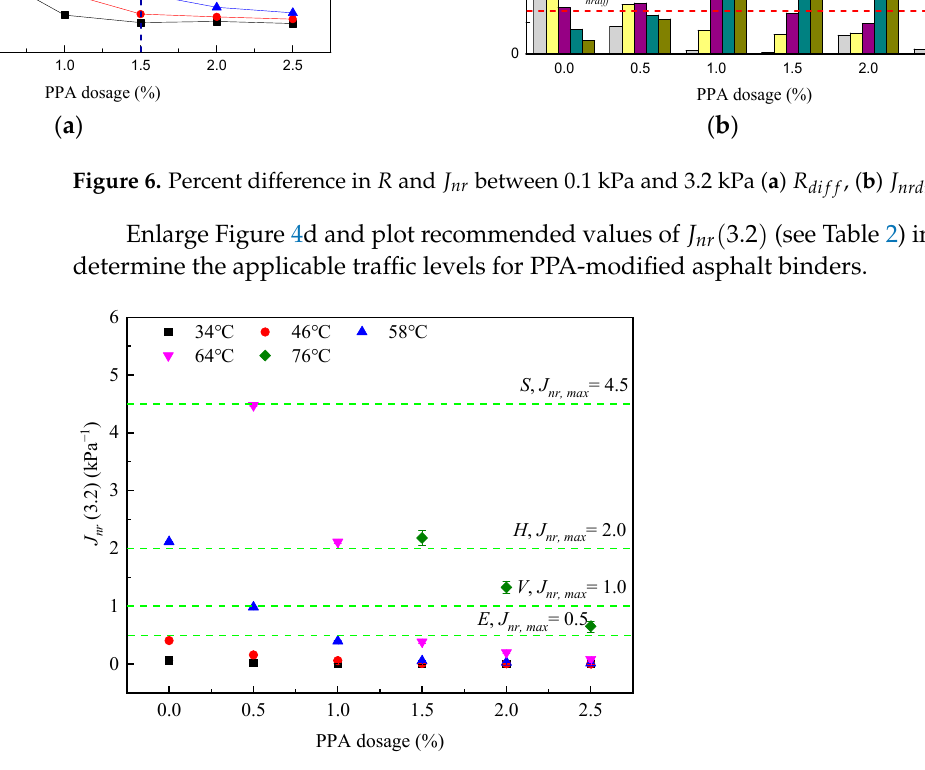
Table 3. Suggested tra ffi c levels for PPA-modi fi ed asphalt binders. Conditions